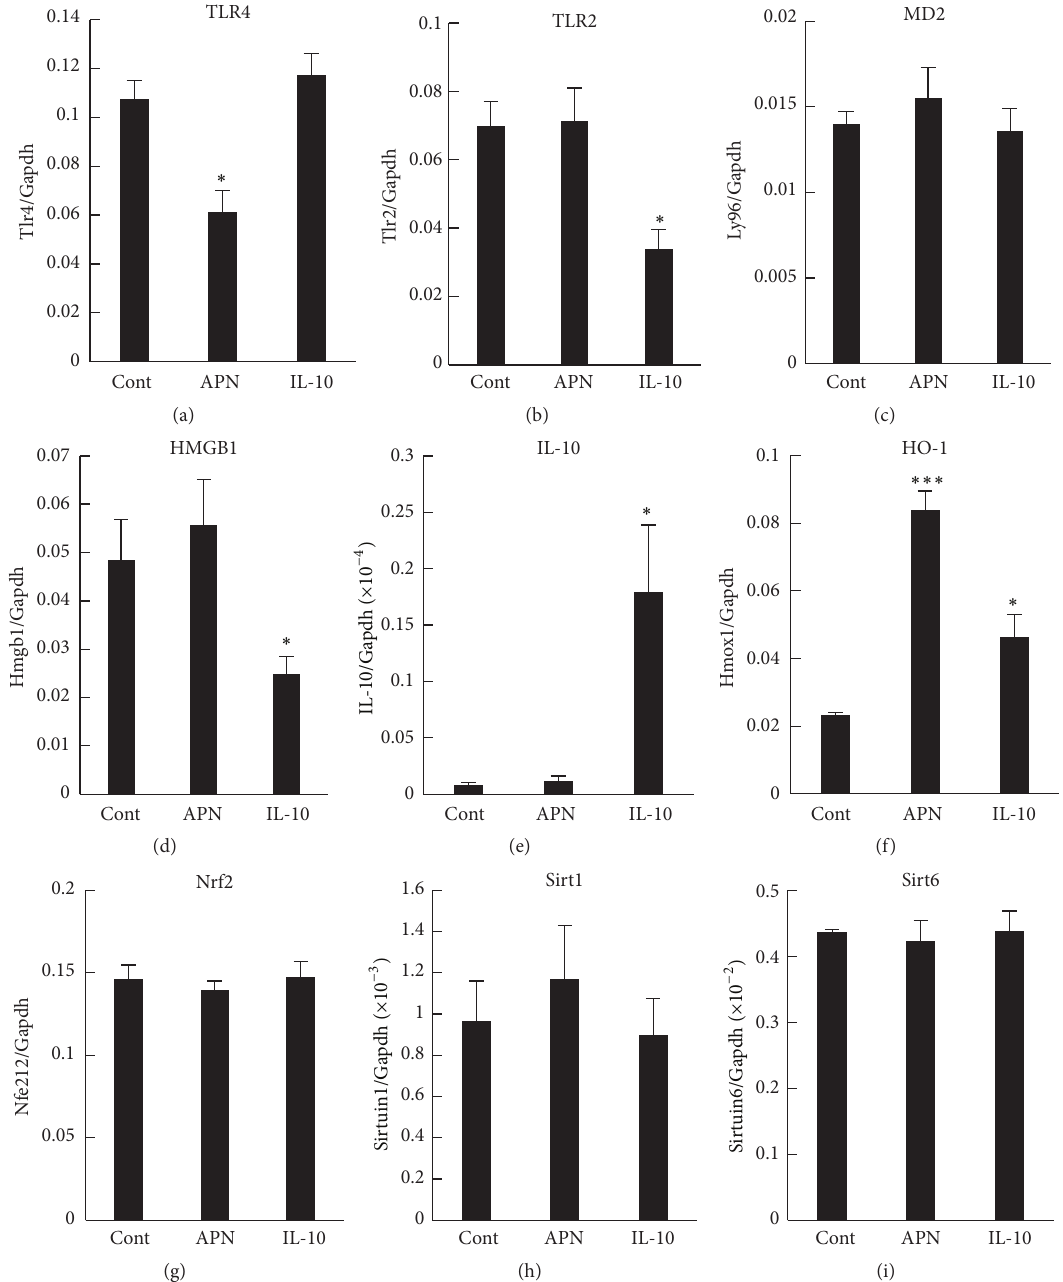
Figure 3: Effects of adiponectin and IL-10 on mRNA expression in RAW 264 cells. Raw 264 cells were cultured as described in Figure 1 legend and were treated with adiponectin (APN, 10 𝜇 g/mL) and IL-10 (100ng/mL) for 18h. RNA was extracted, and expressions of (a) TLR4, (b) TLR2, (c) MD2, (d) HMGB1, (e) IL-10, (f) HO-1, (g) Nrf2, (h) Sirt1, (i) Sirt6, and Gapdh (control) mRNAs were measured using qRT-PCR. The results are expressed as means ± SE of three independent experiments ( ∗∗∗ 𝑝 < 0.001 and ∗ 𝑝 < 0.05 significance compared with control